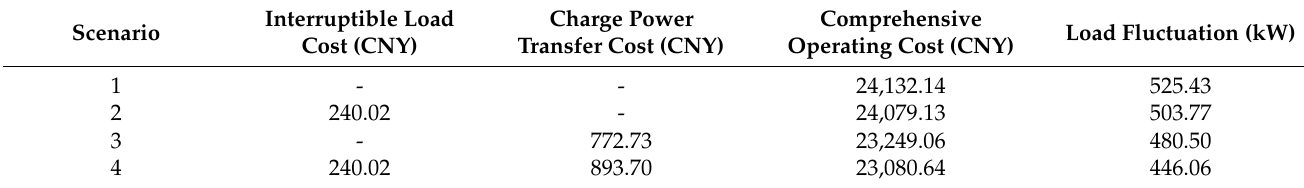
Table 2. Comparative analysis of operating costs in different